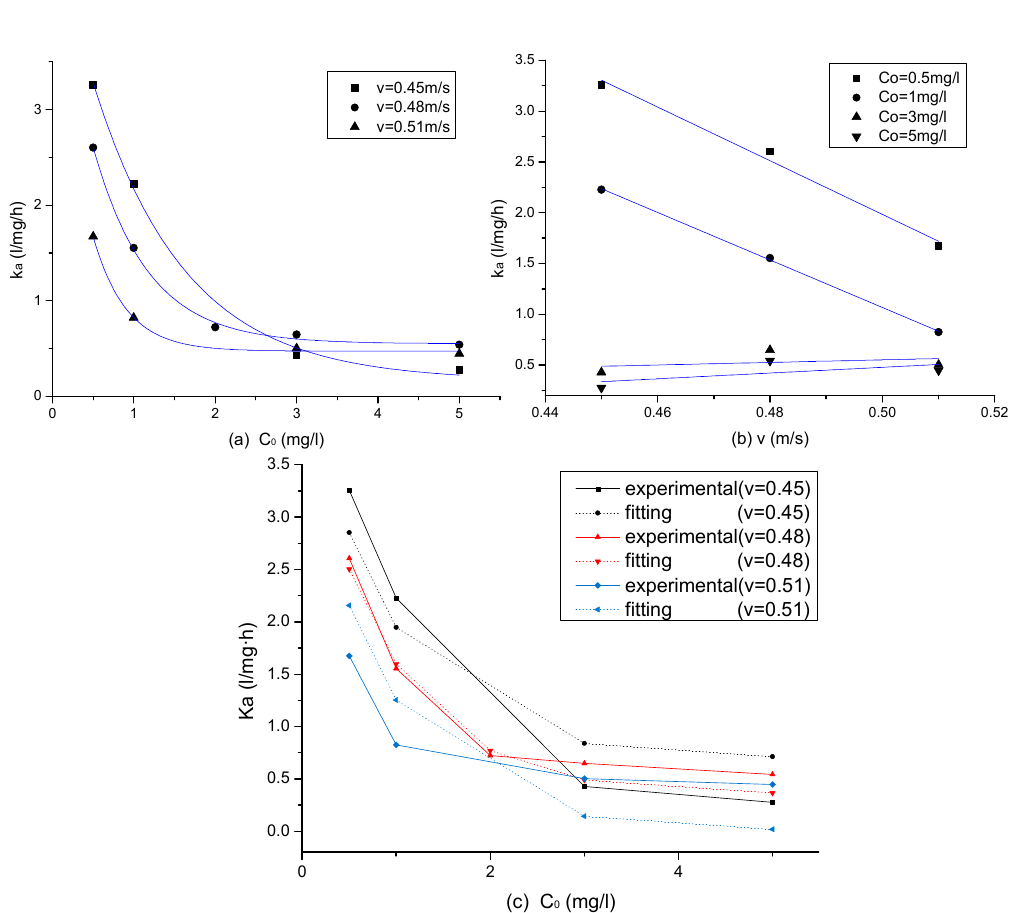
k and v, C ( a , b ) and the comparison between the fitting and Figure 2. Relationships of Figure 2. Relationships of k a and v, C 0 ( a , b ) and the comparison between the fitting and experimental 0 a k with different cases ( c ). ratio k a with different cases ( c experimental ratio a